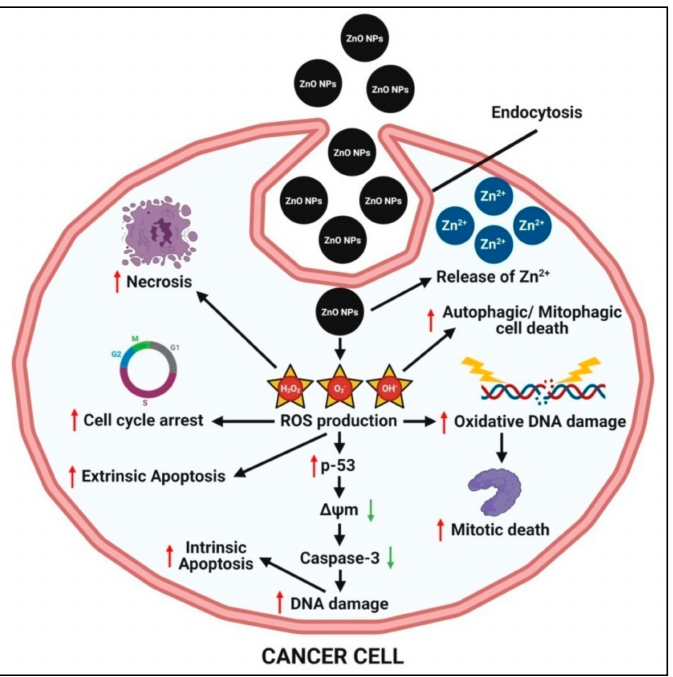
Figure 5. Possible anticancer mechanism of plant-mediated zinc oxide